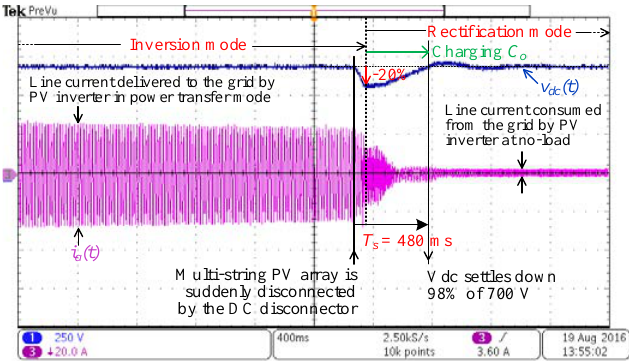
Figure 25. v dc ( t ) and i a ( t ) waveforms recorded by Tektronix MSO3034 oscilloscope, Tektronix P5205A high voltage differential probe Tektronix TCP404XL current probe and Tektronix TCPA300 current probe amplifier when the multi-string PV array is suddenly disconnected from MPPT